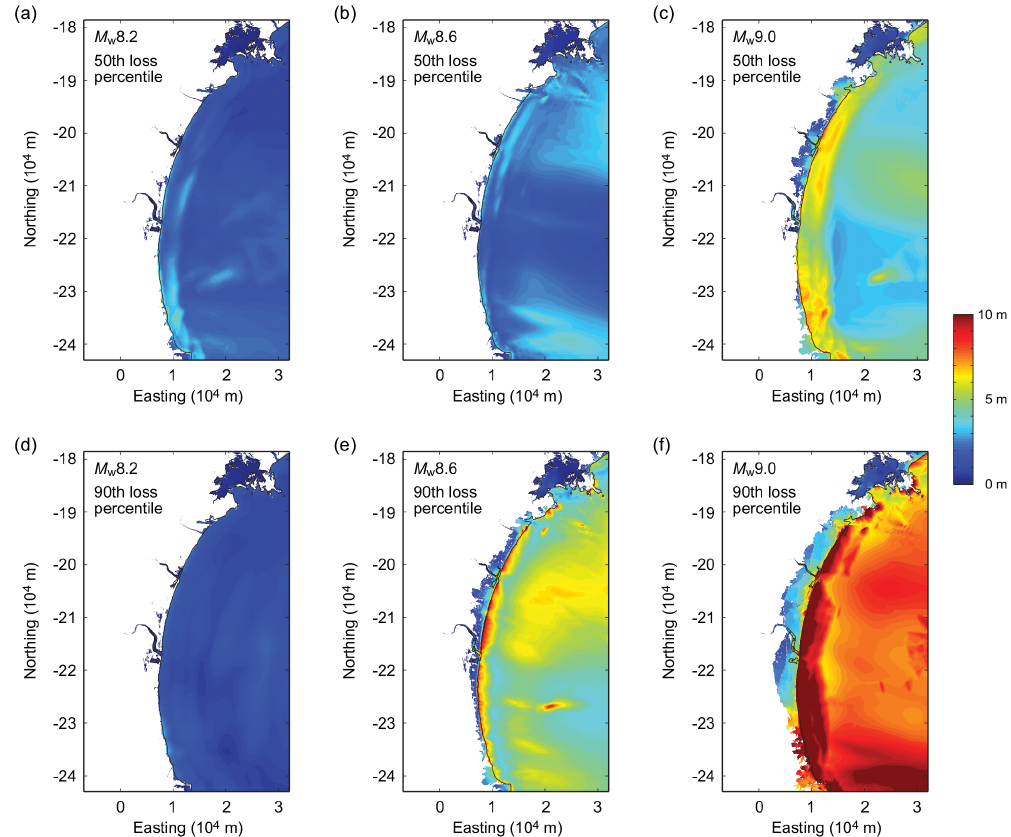
Figure 11. Inundation height maps in Sendai-Soma areas corresponding to critical loss scenarios: (a) 50th loss percentile for M w 8.2, (b) 50th loss percentile for M w 8.6, (c) 50th loss percentile for M w 9.0, (d) 90th loss percentile for M w 8.2, (e) 90th loss percentile for M w 8.6, (f) 90th loss percentile for M w 9.0. The inundation height maps are shown in the Japanese plane orthogonal coordinate